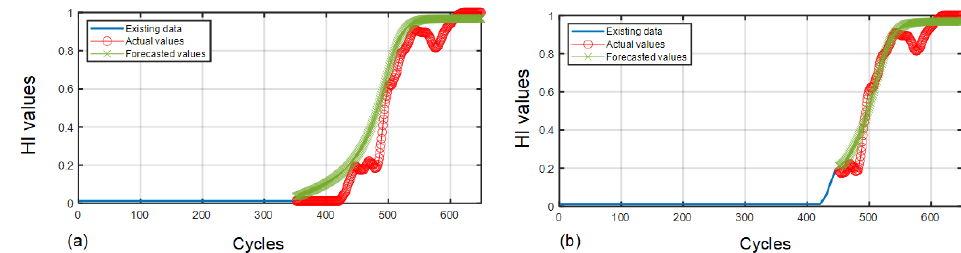
Figure 15. LSTM-RNN-based RLU prediction results of concrete beam B: ( a ) at cycle 350; ( b ) at cycle 450.